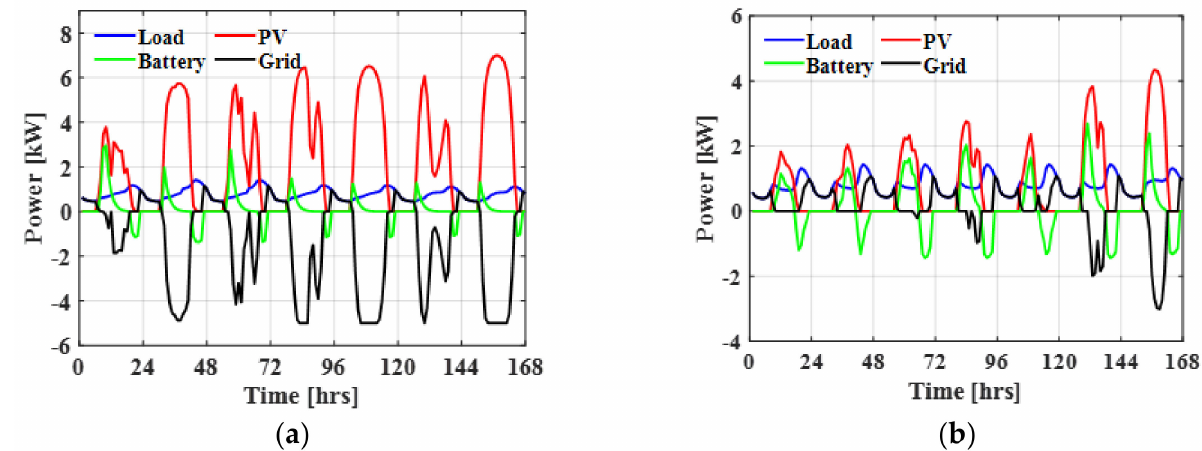
Figure 8. Weekly power flow of the household under ToU-Flat rates: ( a ) Summer week, and ( b ) Winter week.